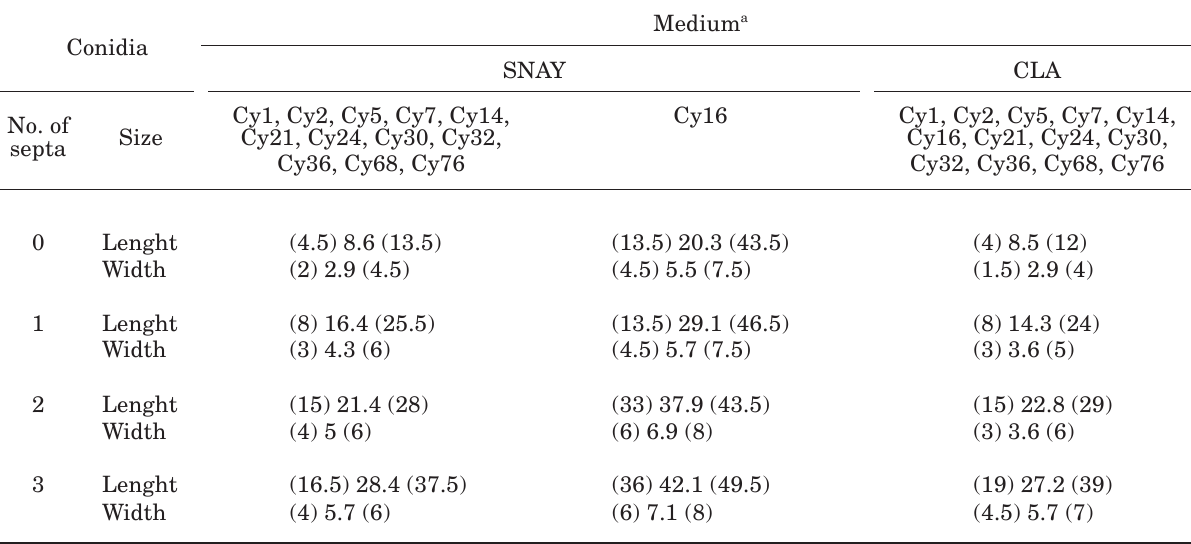
Table 3. Conidial size (µm) of Cylindrocarpon destructans isolates in “Spezieller Nährstoffarmer Agar” plus 0.1% yeast extract (SNAY) and carnation leaf agar (CLA).